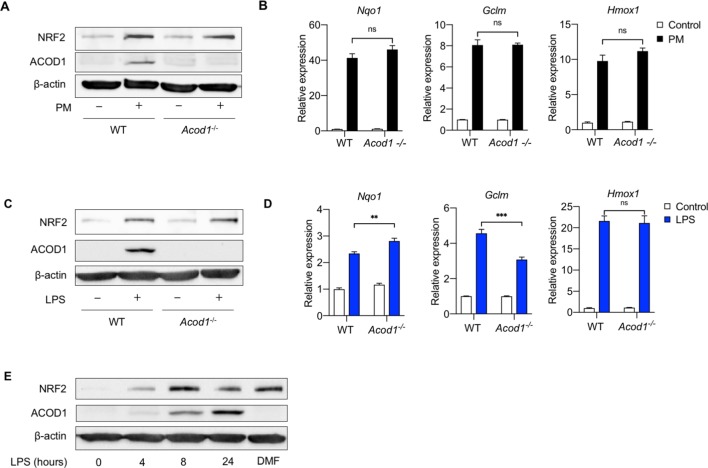
Acod1 and endogenous Itaconate production is not required for PM and LPS-induced activation of NRF2 pathway.(A, B) We treated WT and Acod1-/- BMDMs with PM for 24 hours and measured (A) protein expression of NRF2 (Western blot) and (B) mRNA expression of NRF2 target genes Nqo1, Hmox1 and Gclm (qPCR). NRF2 protein and target genes are unchanged between WT and Acod1-/- (C, D) We treated WT and Acod1-/- BMDMs with LPS (100 ng/ml) for 24 hours and measured (C) protein expression of NRF2 (Western blot) and (D) mRNA expression of NRF2 target genes Nqo1, Hmox1 and Gclm (qPCR). NRF2 protein is not different between WT and Acod1-/- cells. (E) We treated WT BMDMs with LPS for 4, 8, and 24 hours and measured protein expression of NRF2 and ACOD1 (Western blot) over time. Dimethyl fumarate (DMF, 0.1 mM) was used as a positive control for NRF2 expression. The expression of NRF2 precedes ACOD1 and the peak expression of NRF2 occurs before the peak expression of ACOD1. Significance of qPCR data was analyzed with one-way ANOVA corrected with Bonferroni’s post hoc test for multiple comparisons, *p<0.05, **p<0.01, ***p<0.001.